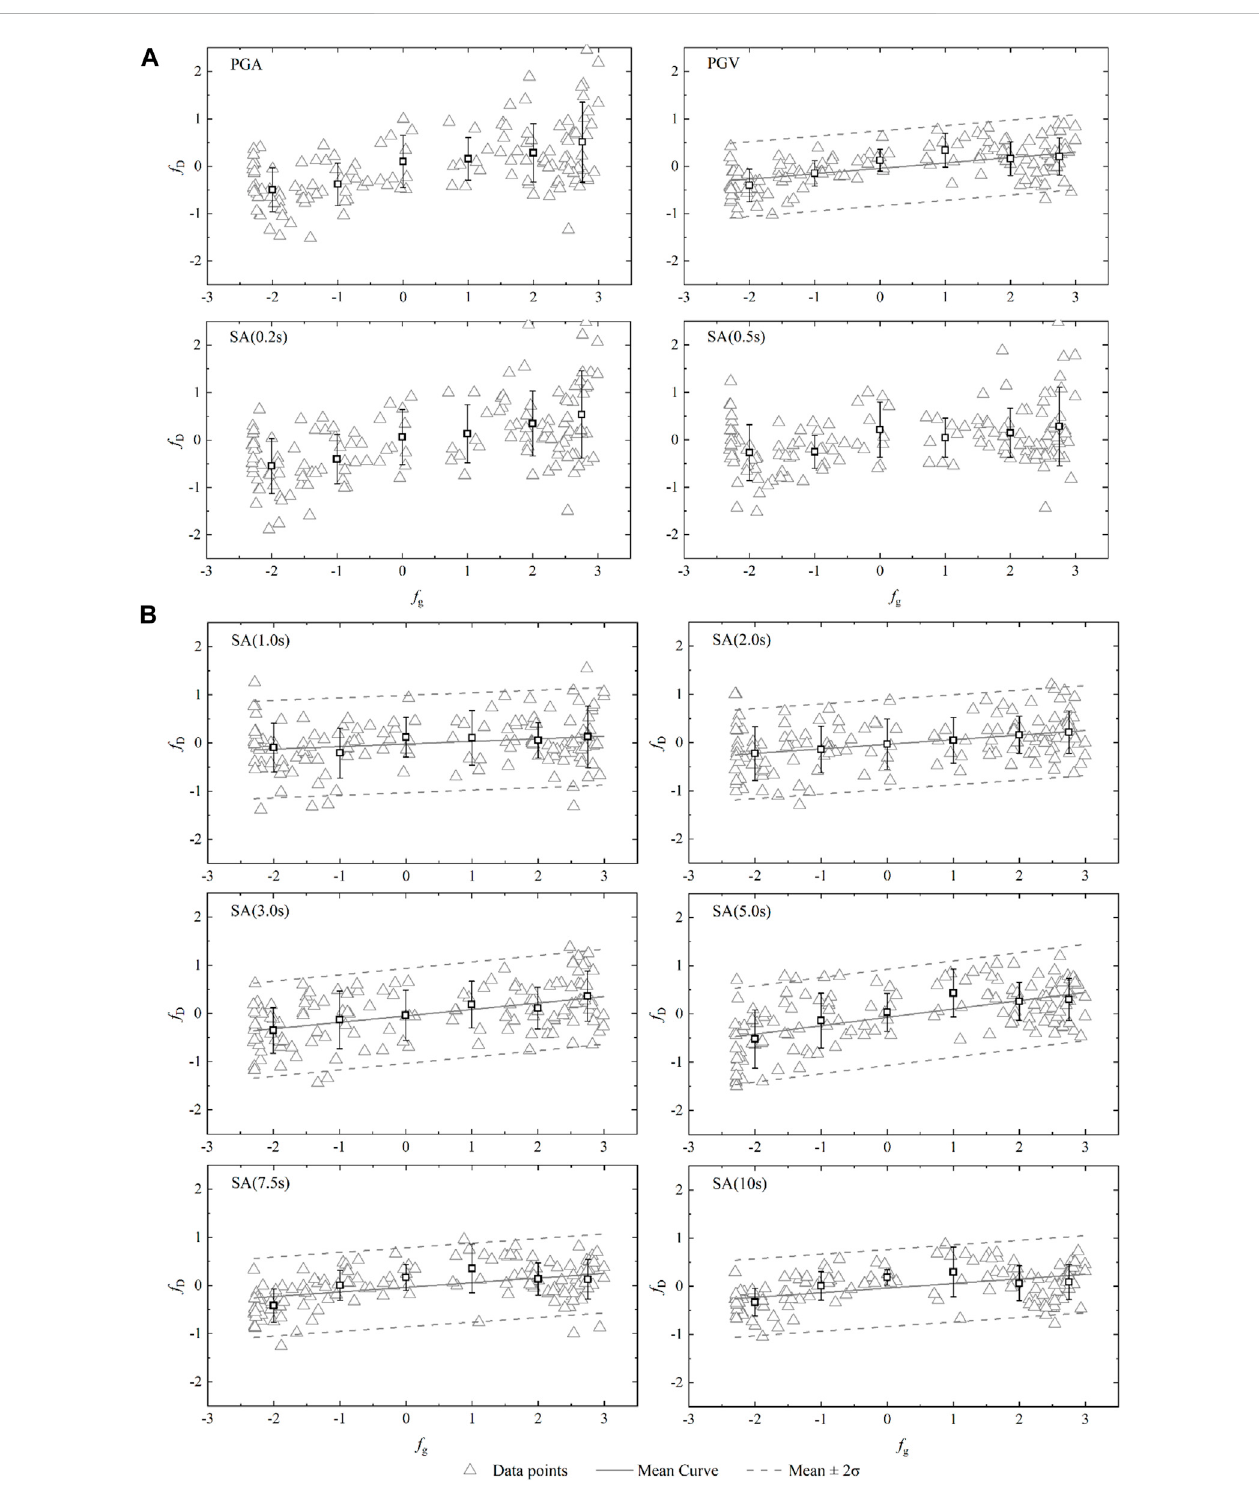
FIGURE 9 Variations in residuals with geometric directivity predictor f g for various IMs (A) PGA, PGV, and short-period ground motion of less than 1.0 s; (B) Long- period ground motion of greater than 1.0 s. The mean curve represents the curve obtained via linear regression of the residuals and the geometric directivity predictor; σ is the root-mean-square error from the linear regression. The vertical bars represent the mean and standard deviation of the binned data.